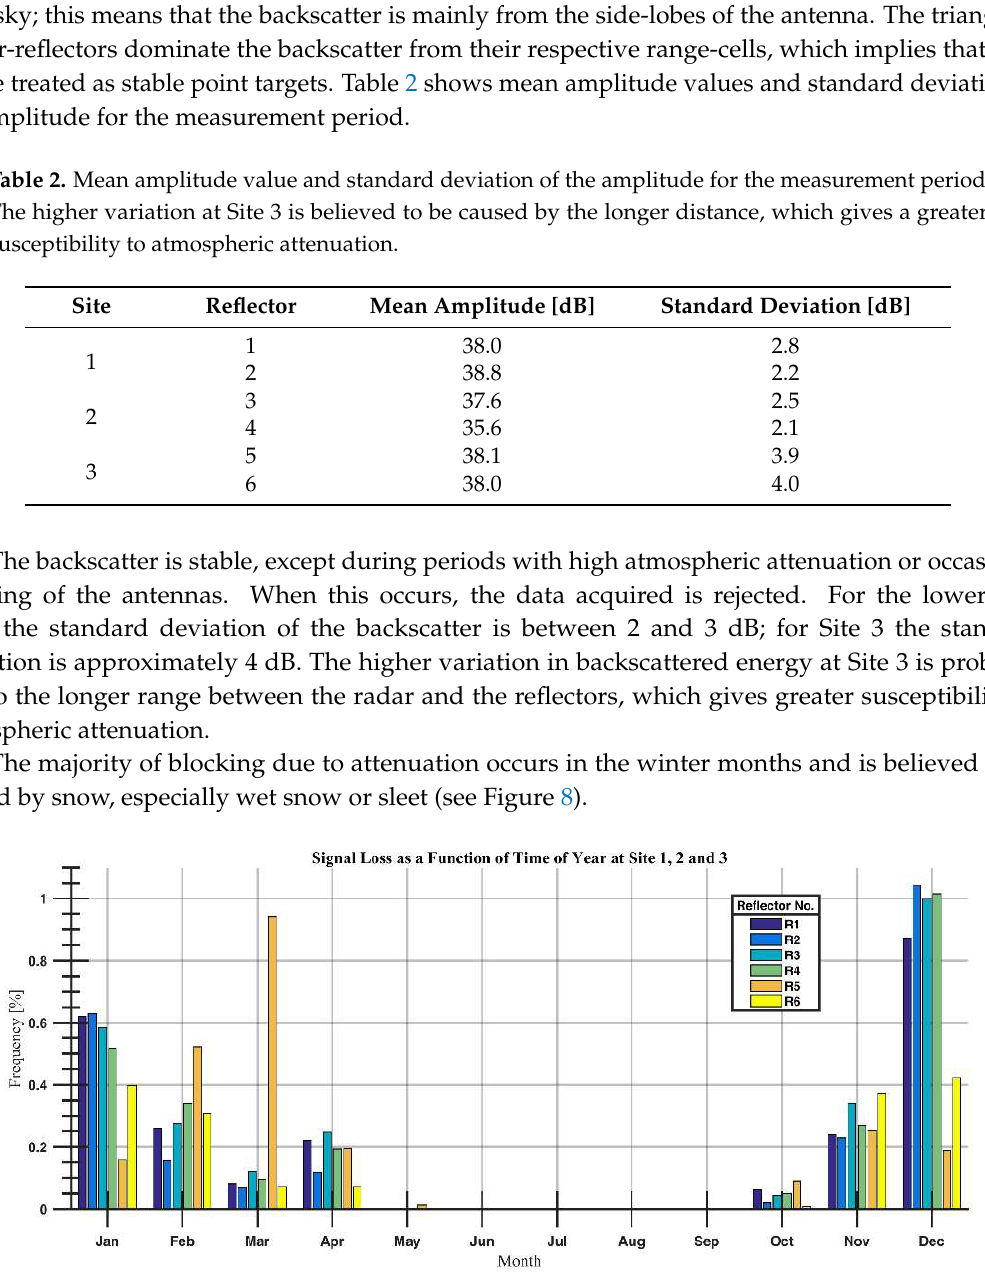
Table 2. Mean amplitude value and standard deviation of the amplitude for the measurement period.